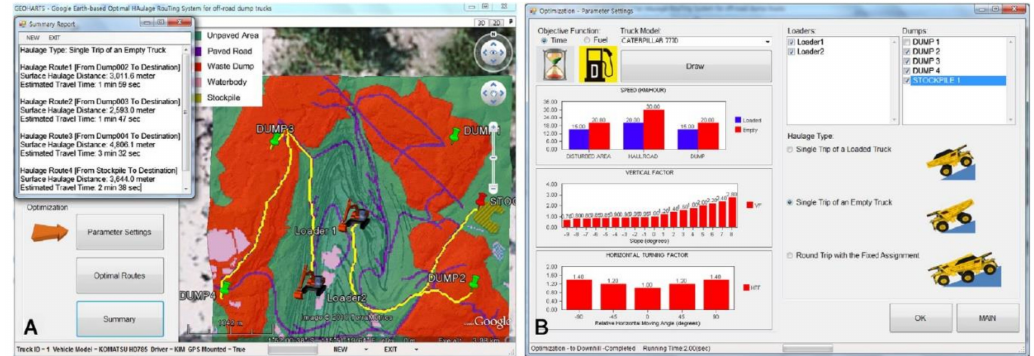
Figure 11. Visualization of the Google Earth-based Optimal Haulage Routing System (GEOHARTS) software for optimal haulage planning in an open-pit mine. ( a ) Optimal haulage routes of empty trucks that ensure the least travel time. ( b ) Parameter settings for haulage route analysis